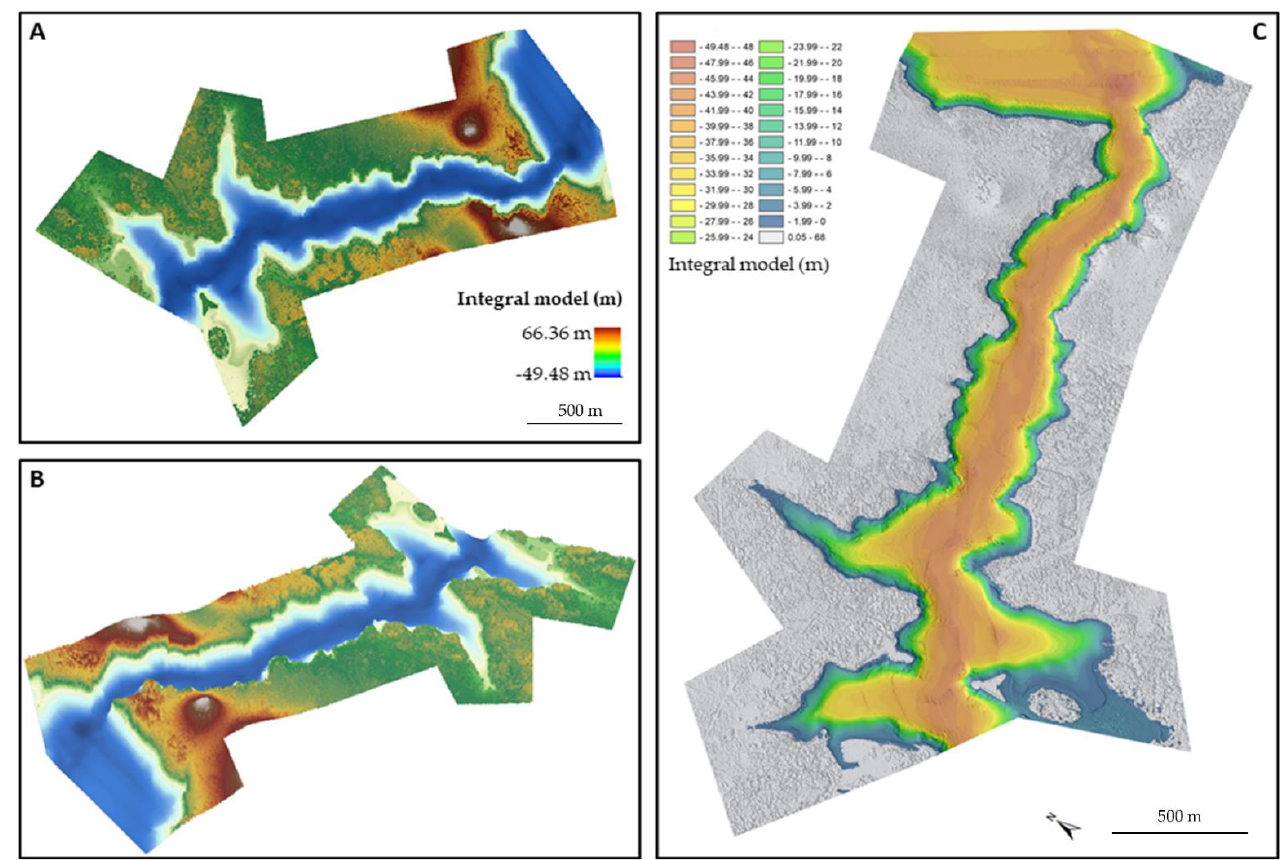
Figure 16. ( A ) The integral (MBES and UAV) model of the St. Anthony Channel; ( B ) the 3D view of the St. Anthony Channel; ( C ) the bathymetric map of the St. Anthony Channel.